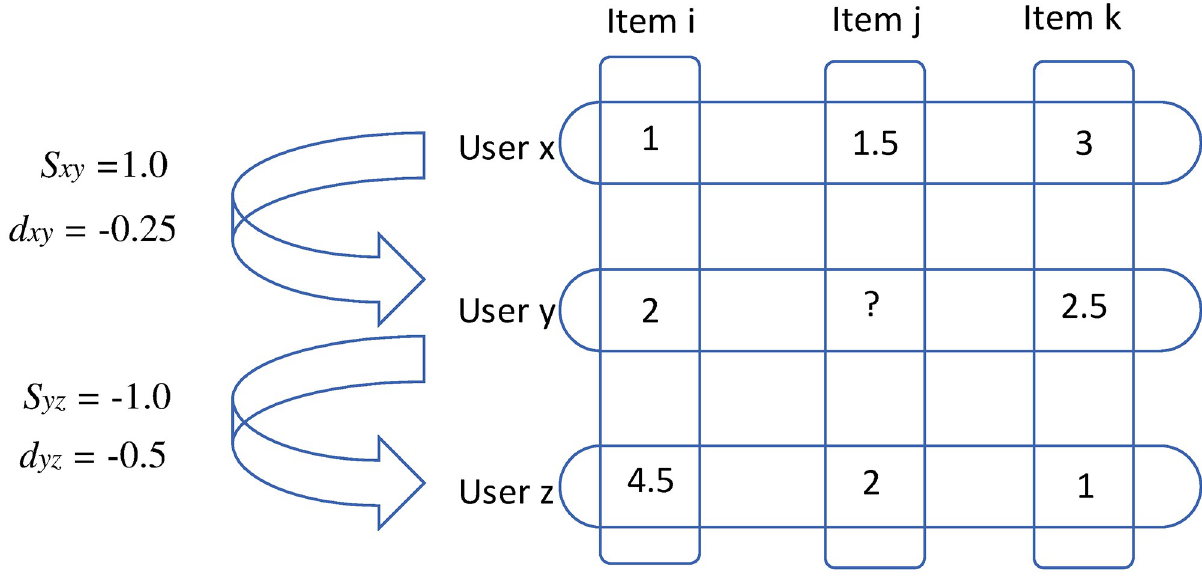
Fig 1. Ratings of three movies by three users are shown in a schematic diagram of traditional algorithms. s is given by similarity measurement and d is calculated by distance